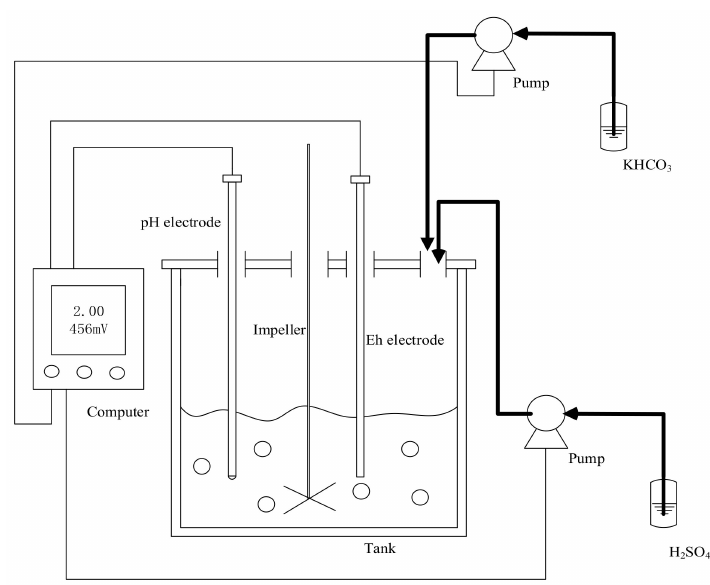
Figure 1. pH-stat batch stirred tank reacting